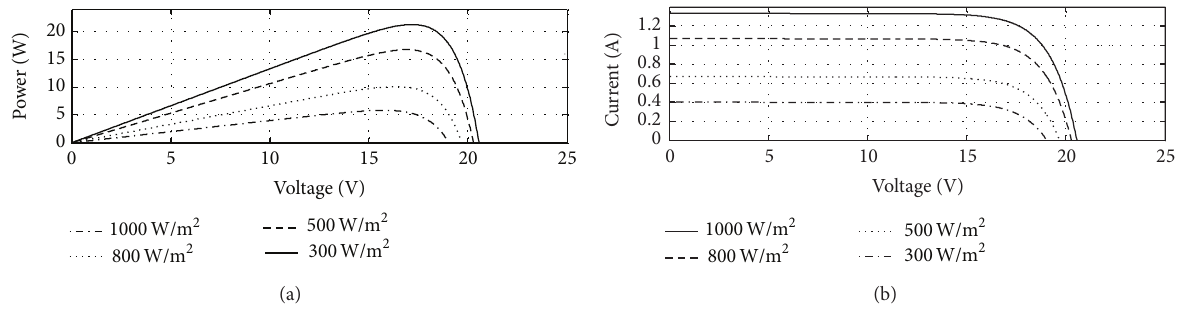
Figure 9: SA characteristics at different insolation: (a) 𝑃 - 𝑉 characteristic and (b) 𝐼 - 𝑉